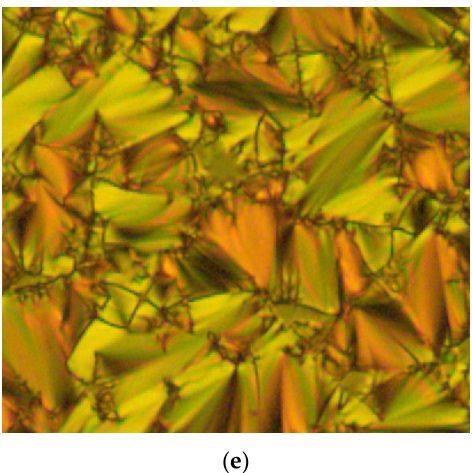
Figure 11. The optical photomicrographs of intermediates 2a–e in the cooling cycle showing the focal conic fans of SmA phase, ( a ) 2a at 97.77 ◦ C, ( b ) 2b at 94.24 ◦ C, ( c ) 2c at 94.37 ◦ C, ( d ) 2d at 80.34 ◦ C, and ( e ) 2e at 83.11 ◦ C (Magnification of 20 × 0.50).